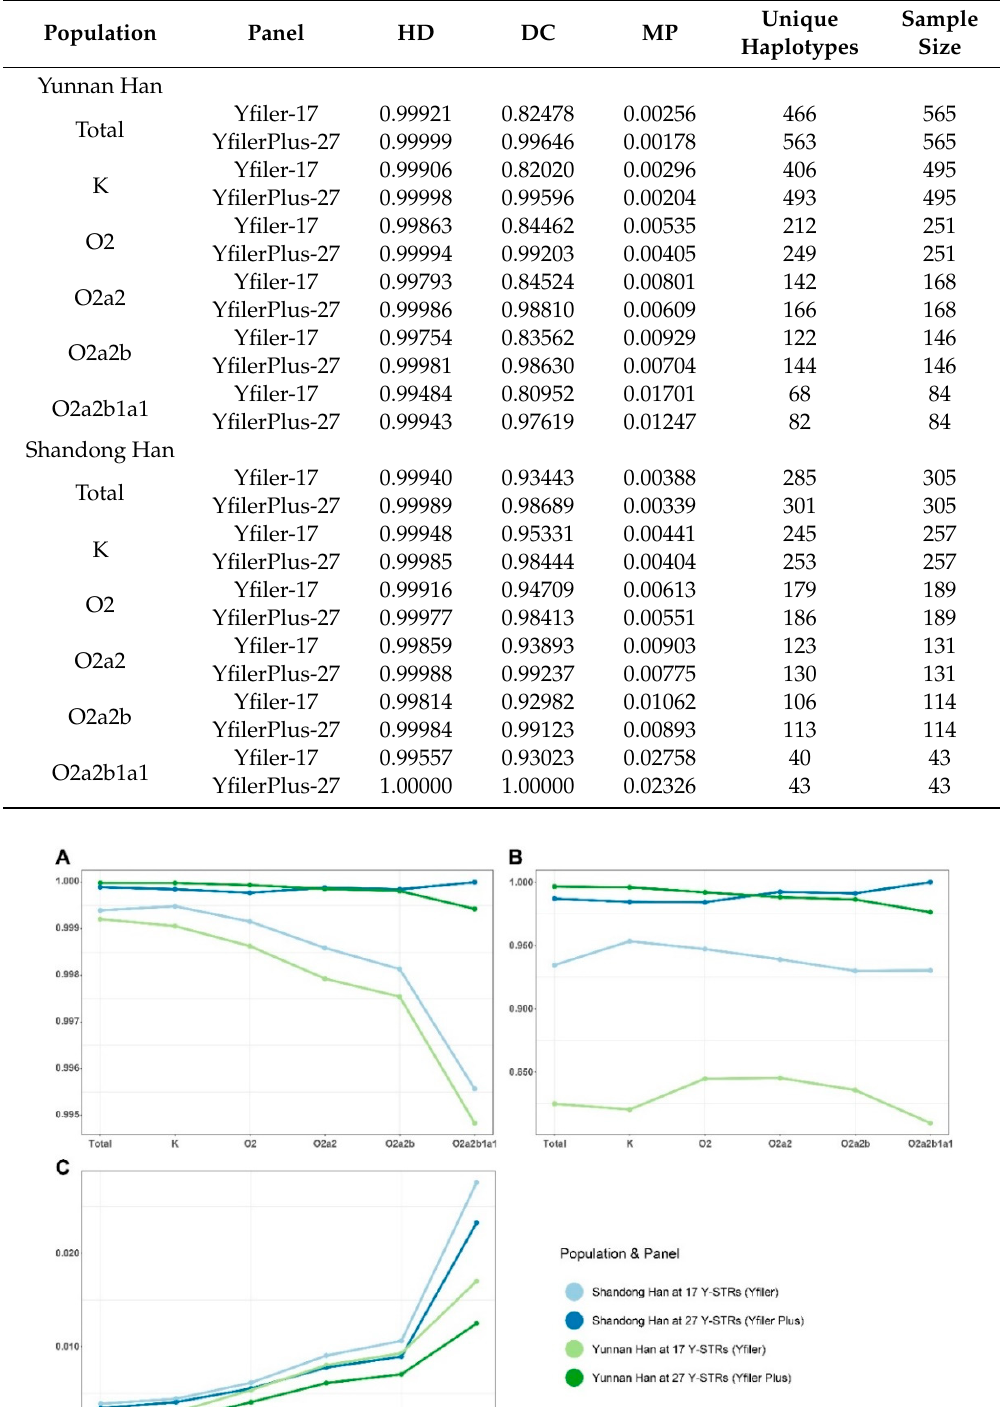
Table 1. Standard forensic parameters based on 17 or 27 Y-STR loci for the whole groups of Shandong and Yunnan Han, as well as for the sub-populations defined by Y-SNPs.